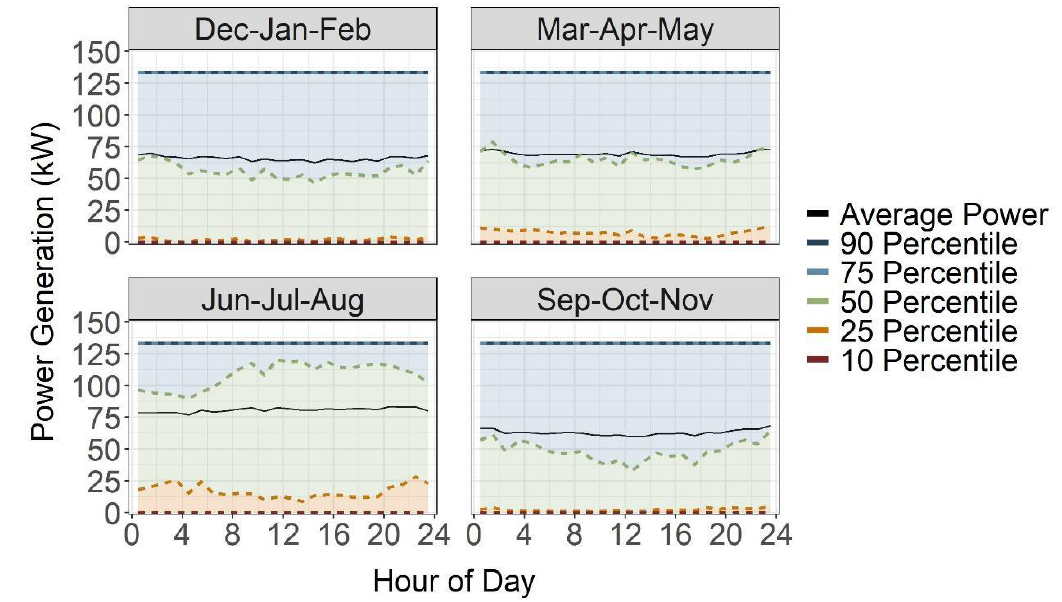
Figure 10. Average hourly power generation of the 144 MW farm in the Humboldt call area by season. Each line represents a different likelihood of occurrence, 10%, 25%, 50% (the median), 75%, or 90%. The green dashed line, at the interface between the blue and green range, shows the median power output or 50th percentile, and the solid line represents the